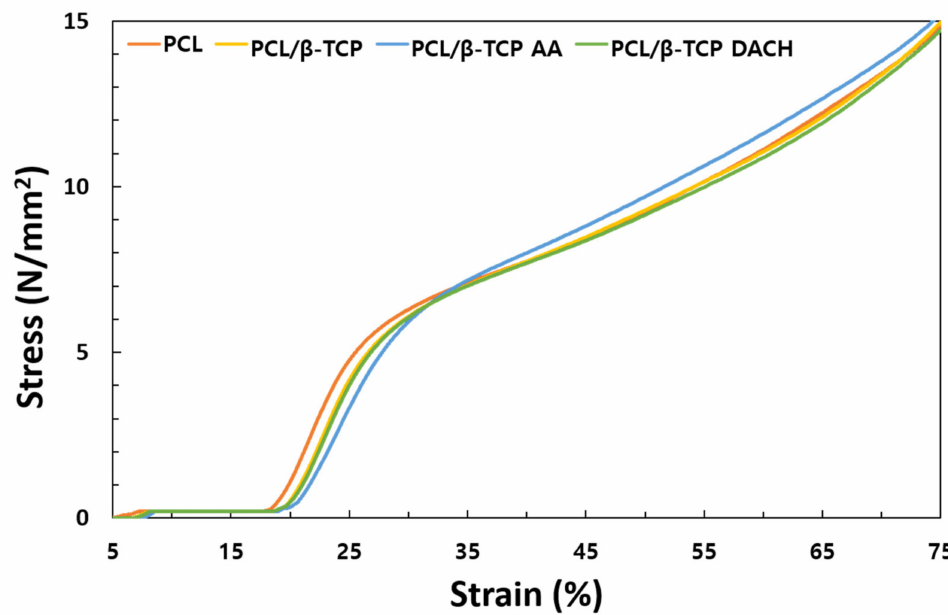
Figure 7. Stress–strain curves obtained for 3D PCL and PCL/ β -TCP scaffolds with a 0/45 ◦ lay-down pattern compressed at cross-head speed of 0.5